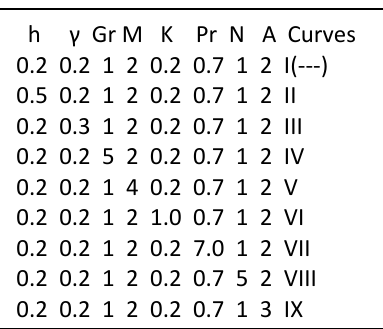
Figure 3. Amplitude of skin friction . Table 2. Sets of parameter values plotted in Figs.3 & 4.